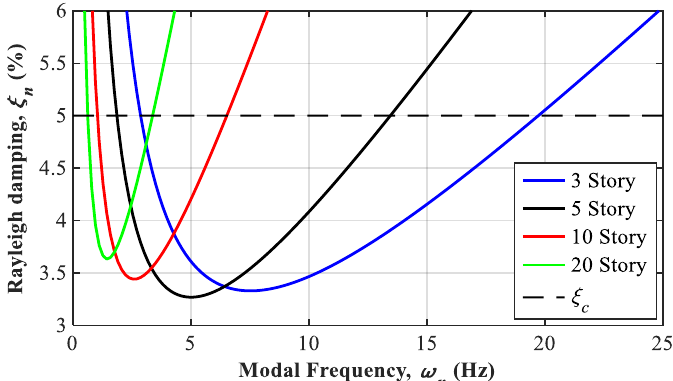
Figure 3. Rayleigh damping ratio with the natural frequency.